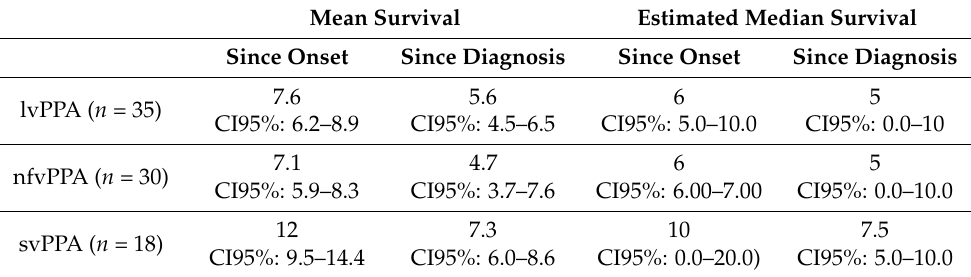
Table 2. Mean and estimated median survival time (years).